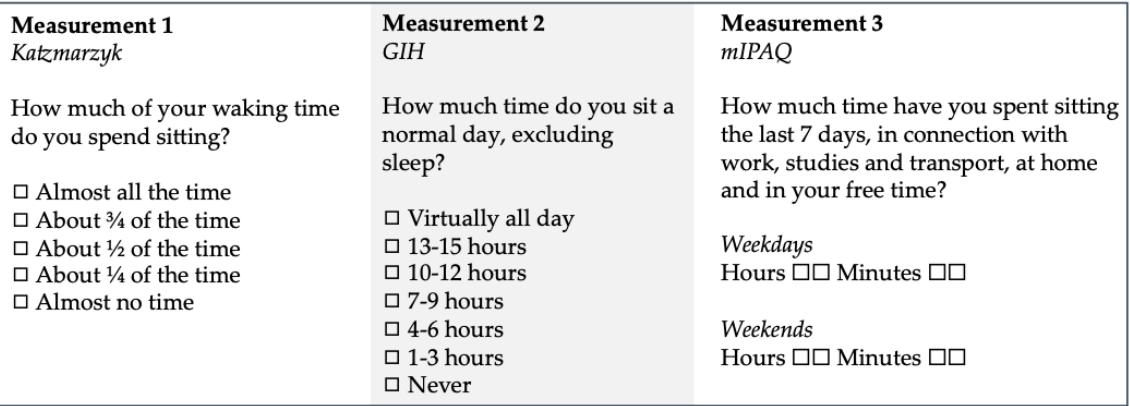
Figure 1. The three different questions for self-report of sedentary behavior at the three different measurements.